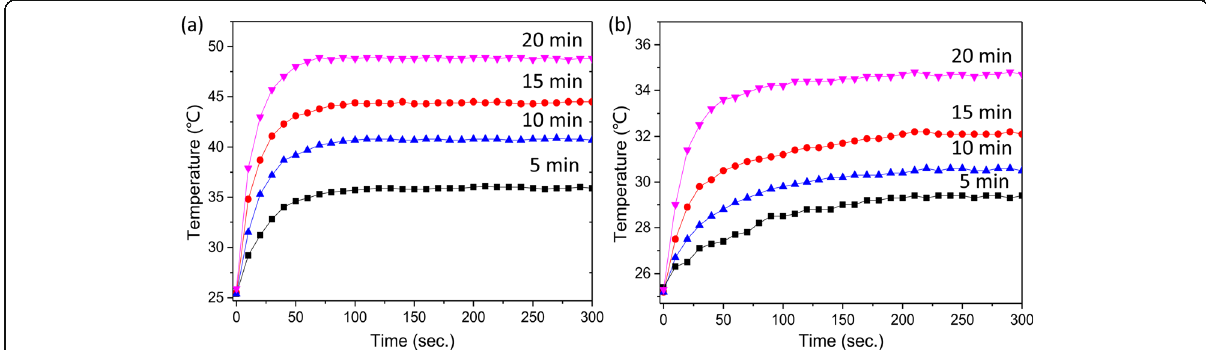
Fig. 7 Temperature (T)-time (t) profiles for the electrospun fiber membranes prepared by in situ electrospinning a with and b without the use of an auxiliary electrode for 5, 10, 15, and 20 min upon the application of